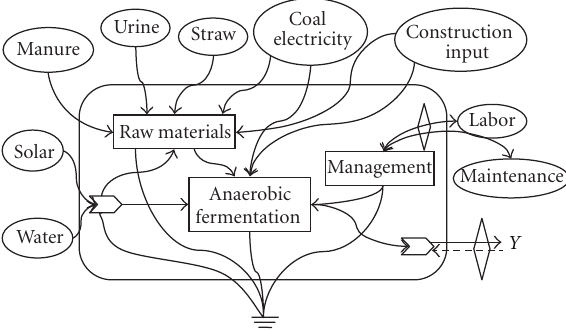
Figure 2: Emergy system diagram of the biogas project.